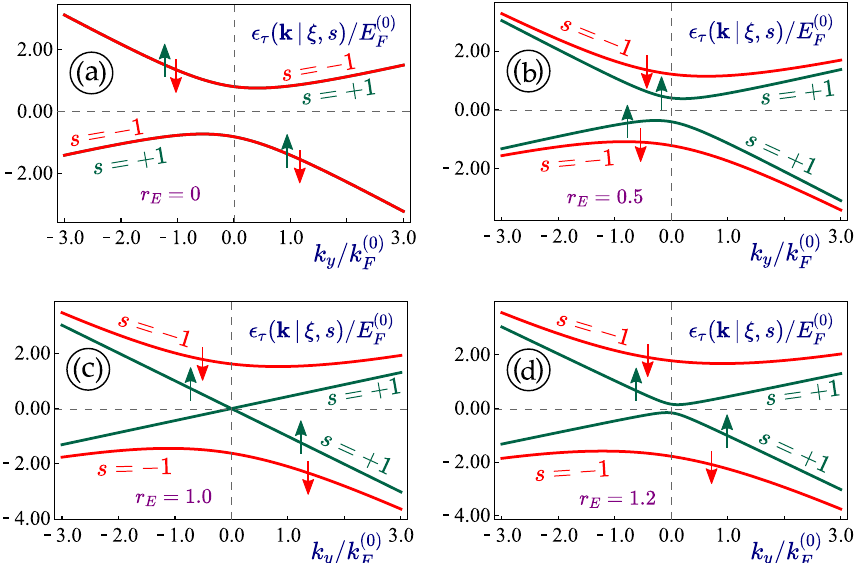
0, k , s ) for non-irradiated 1T y | ξ ′ = 0 , 0.5, 1.0 and = 0 for all 1 and k 1 . Here, we take ξ x = E = =